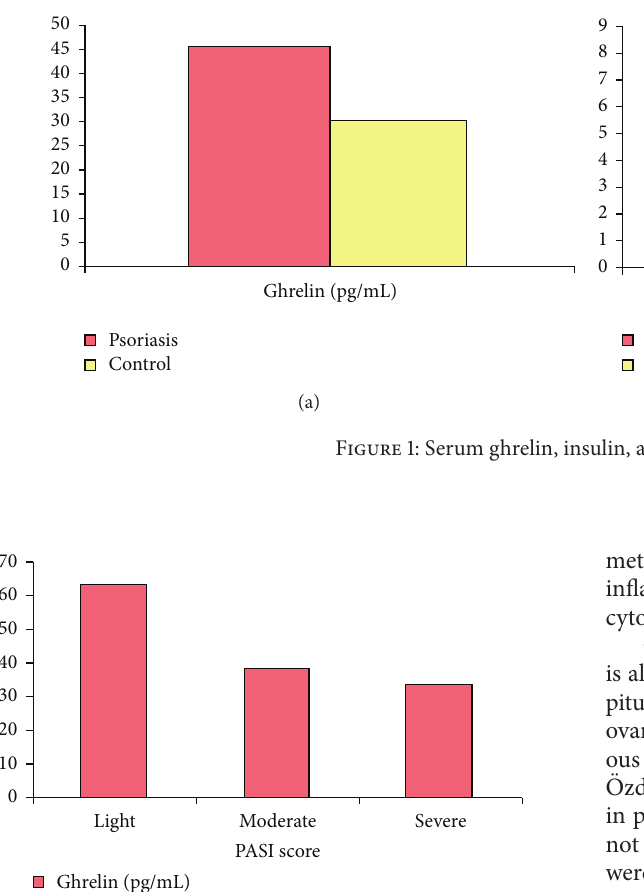
Figure 2: Serum ghrelin levels according to PASI